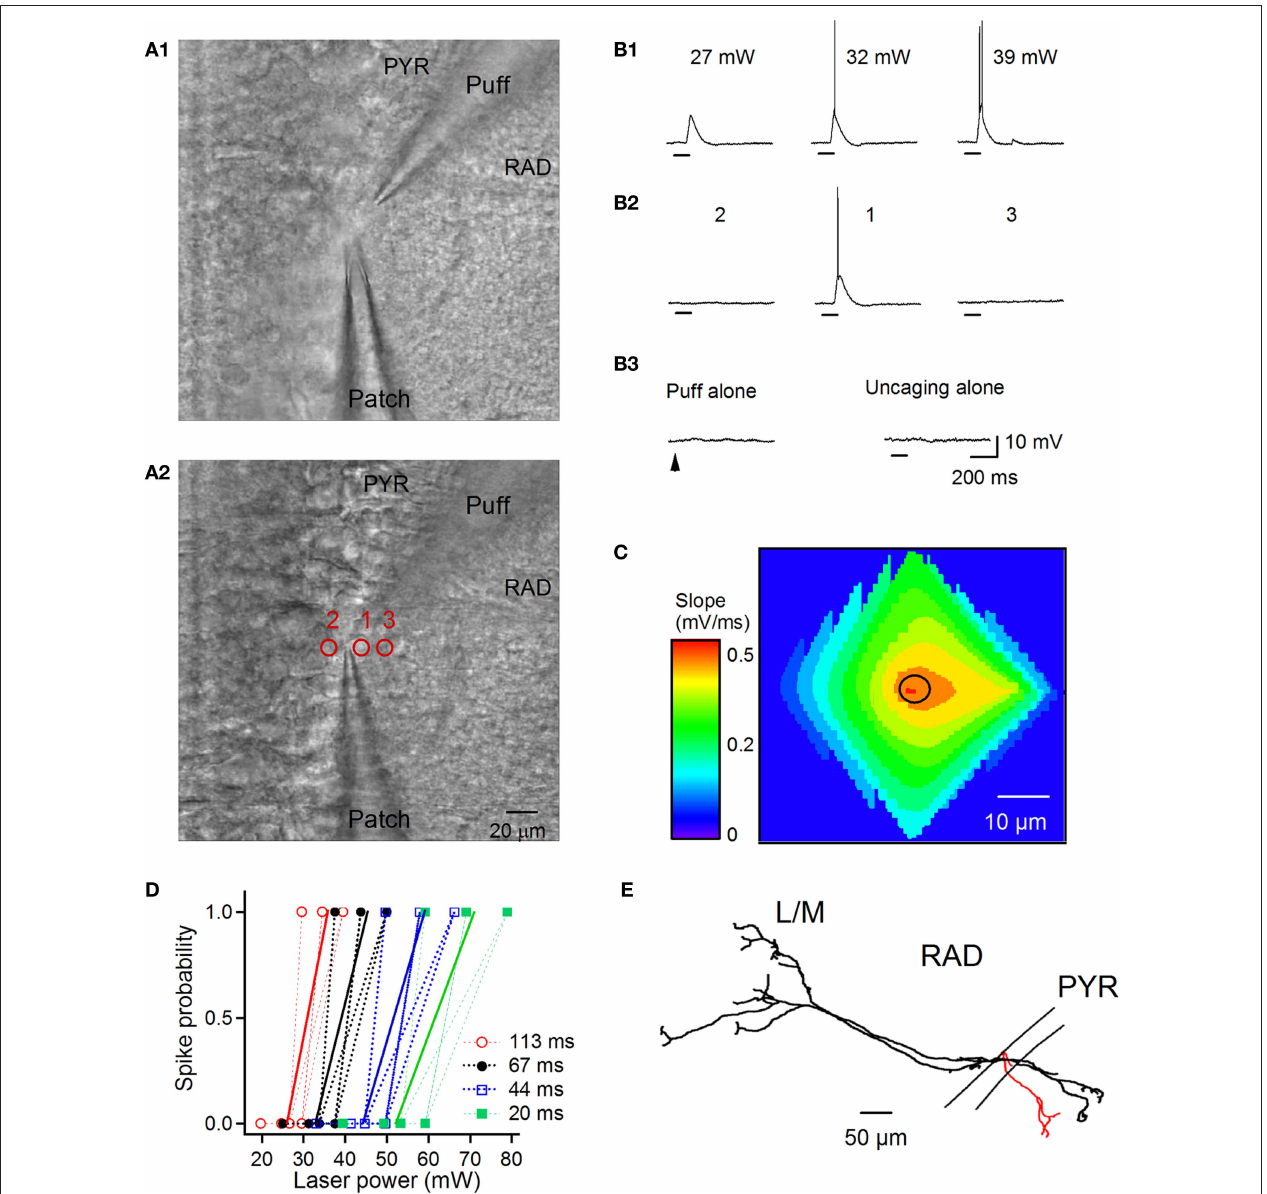
slope of uncaging-evoked responses. A slope of 0.5 ± 0.04 mV/ms corresponds to the EPSP-spike sequence. The black circle indicates the cell body position. Note the high localization of action potential generation at the cell body level. (D) Spike probability as a function of laser power and pulse duration. Dotted lines correspond to individual cells and solid lines to the average spike probability for a given duration. Note that a minimal laser power of ∼ 30 mW was required to evoke a single spike using pulses of 113 ms. Successful photostimulation with shorter uncaging pulses (20–44 ms) required an increase in the laser power above 50 mW. (e) Neurolucida reconstruction of a RAD IN tested for photoexcitability and filled with biocytin. Soma and dendrites are shown in black, and axonal arborization is shown in red.